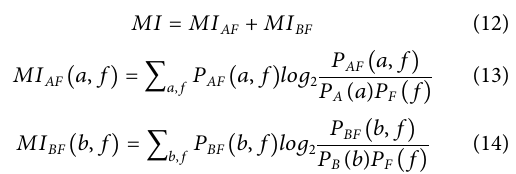
TABLE 5 Comparison results of evaluation metrics for image(d). Method